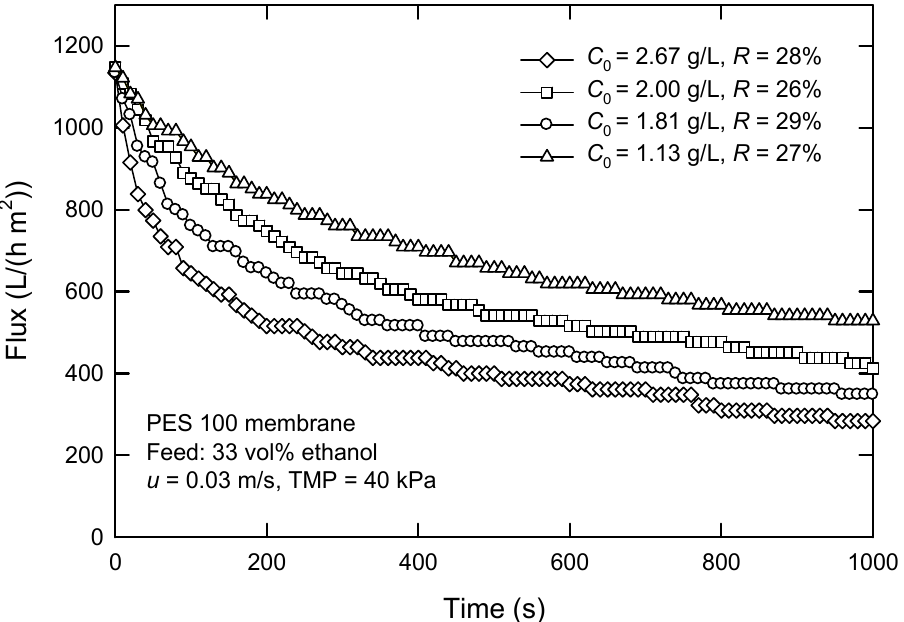
Figure 7. Effect of surfactin concentration C 0 on the flux and surfactin rejection in cross-flow UF using PES 100 membrane.